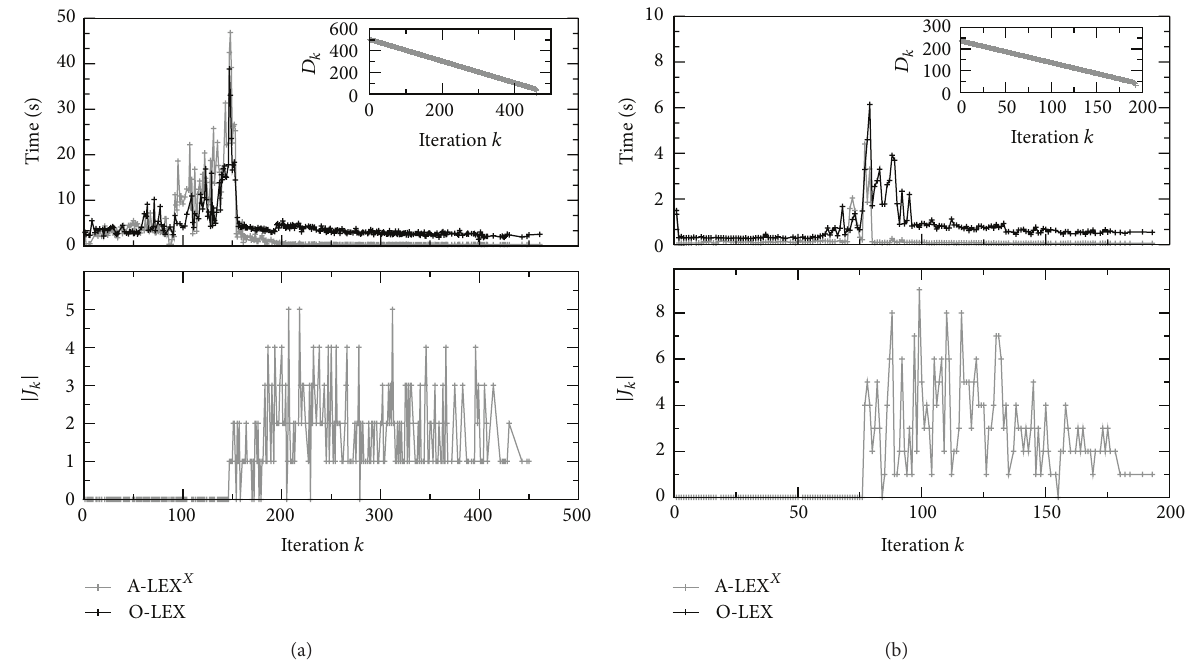
Figure 3: Computational time in seconds and the number of fixed aggregate customers |𝐽 𝑘 | as a function of the iteration step 𝑘 . The results were obtained for the benchmark 𝑆𝐽𝐶4 in (a) 𝑝 = 20 and in (b) 𝑝 = 80 . The values |𝐽 𝑘 | are identical for both algorithms, and the datasets are